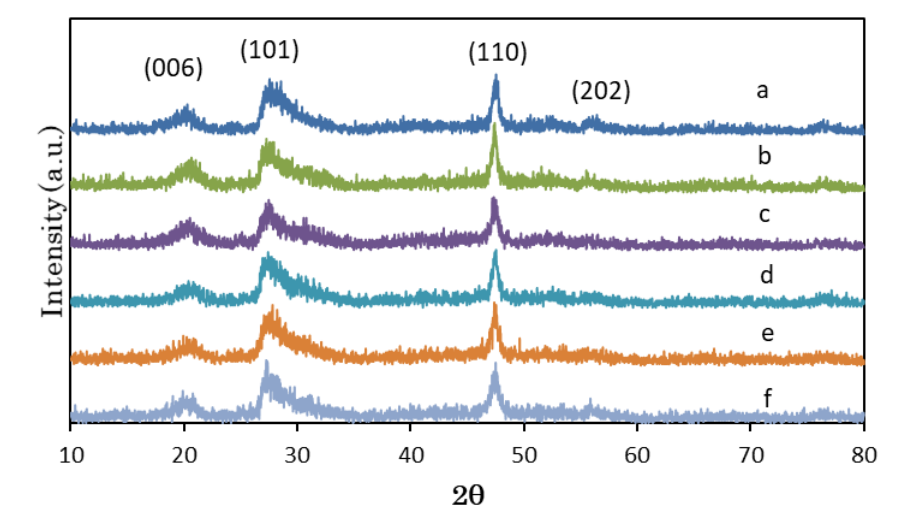
Figure 1. XRD patterns of Zn (1 − 2x) (CuGa) x In 2 S 4 . ( a ) x = 0, ( b ) x = 0.07, ( c ) x = 0.10, ( d ) x = 0.13, ( e ) x = 0.16, and ( f ) x = 0.19.